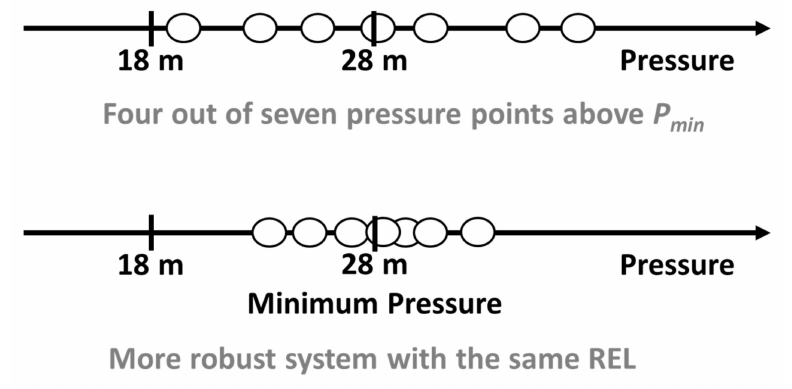
Figure 1. Pressure variations in a robust water distribution